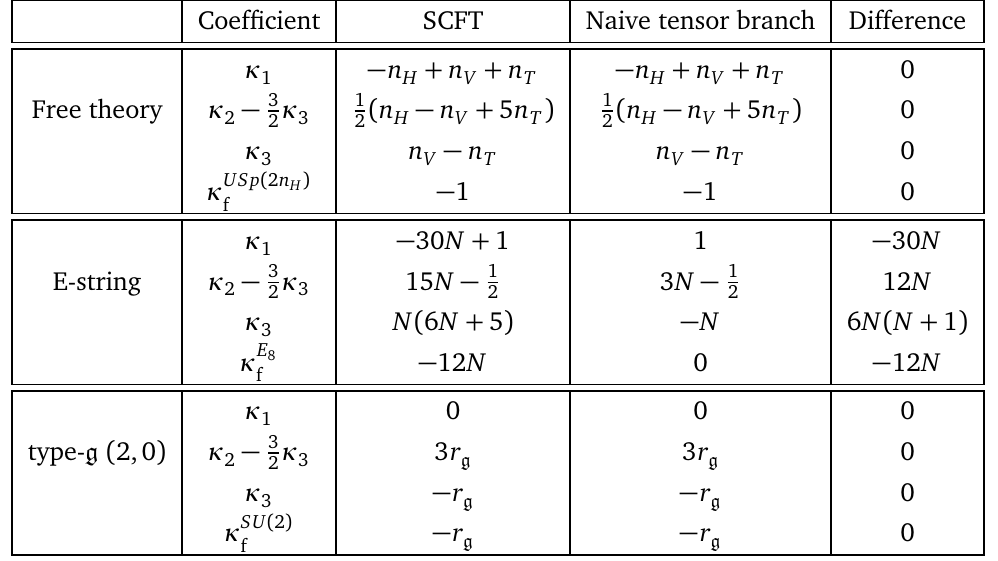
Table 2: Anomaly coefficients κ for an assortment of 6d SCFTs I. We exhibit both 1,2,3 the values computed at the SCFT point using the formula (1.16), and the naive values by simply adding free fields on the tensor